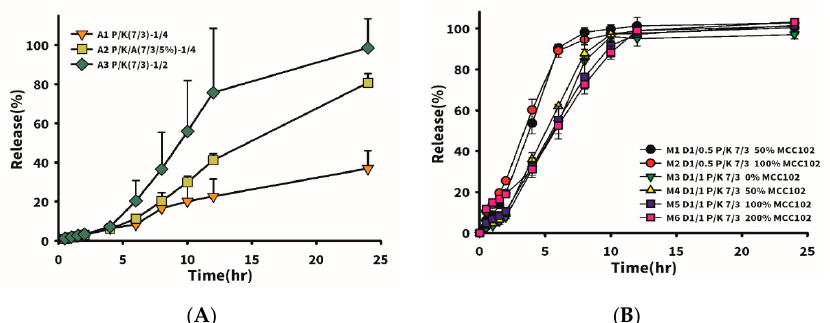
Figure 2. Dissolution profiles of nilotinib in simulated gastric fluid (SGF) from the A1–A3 formulations ( A ) and M1–M6 formulations ( B ).